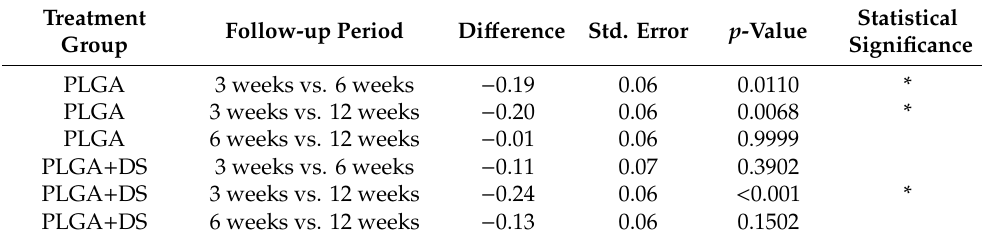
Figure 6. Scatter plot of peri-implant bone capsule (piBC), i.e., the percentage of the rod surface that is surrounded by newly formed bone. (Black dots refer to mean values of the respective groups). Table 1. piBC—test for time differences within the poly(lactide-co-glycolide) (PLGA) and the PLGA+DS8 groups. (* indicates statistical significance at p < 0.05.). Table1. piBC—testfortimedi ff erenceswithinthepoly(lactide-co-glycolide)(PLGA)andthePLGA + DS8 groups. (* indicates statistical significance at p < 0.05.).